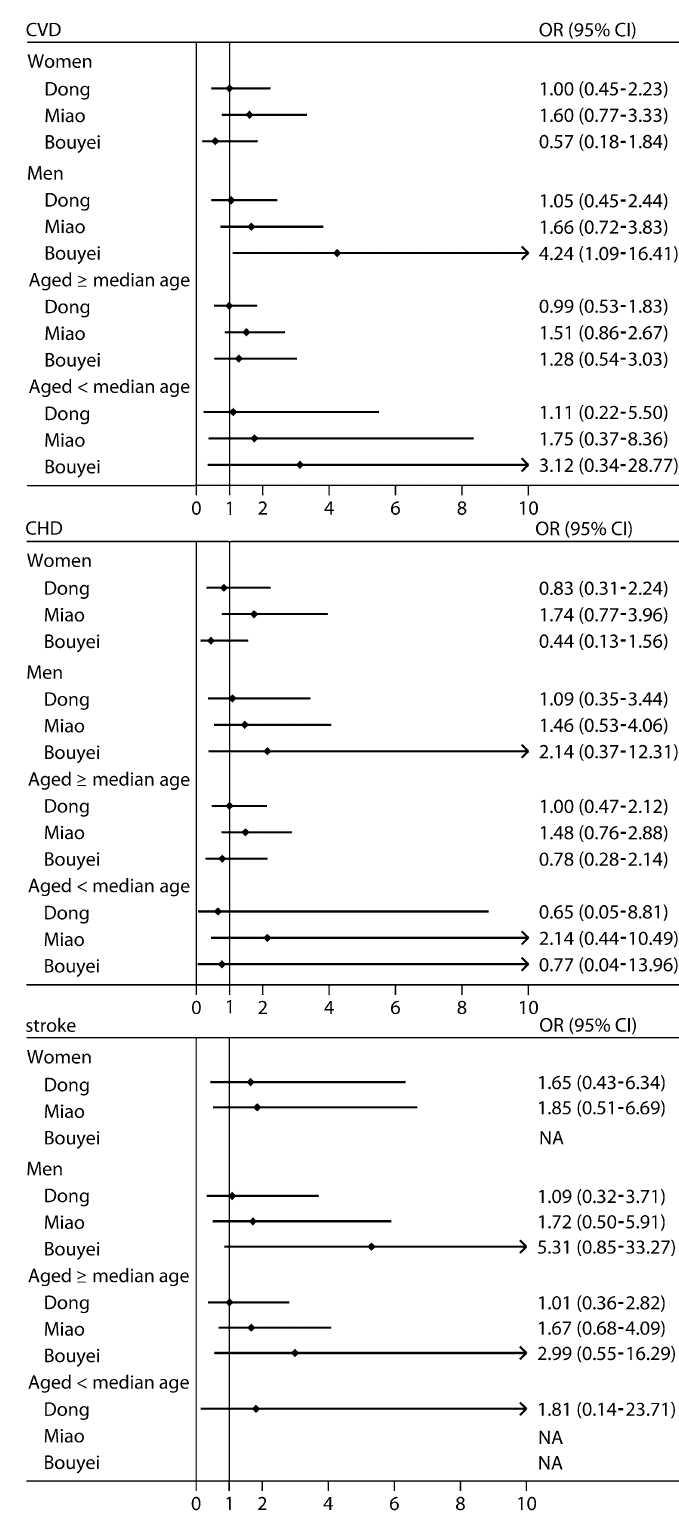
Figure 4. Risk of cardiovascular disease, coronary heart disease, and stroke stratified by sex and age in urban areas. Adjusted for sex, age, educational attainment, annual household income, tobacco smoking status, alcohol drinking status, total physical activity, total energy intake, family history of cardiovascular disease, body mass index, and systolic blood pressure, fasting plasma glucose, and triglycerides levels, except for the stratified variables. CHD coronary heart disease; CI confidence interval; CVD cardiovascular disease; NA , not applicable; OR odds ratio. Median of age were 50, 51, and 53 years among the Dong, Miao, and Bouyei ethnic groups,